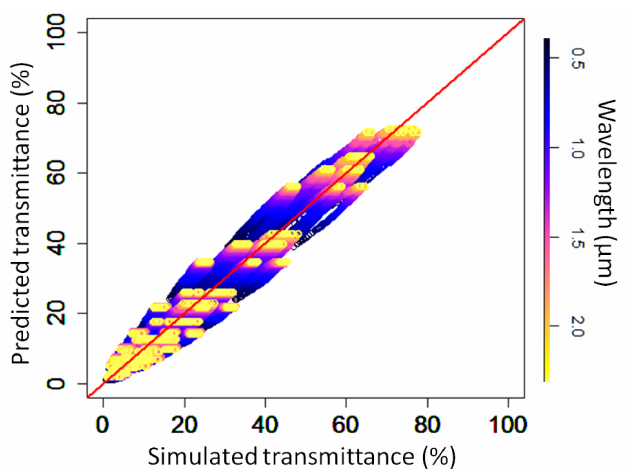
Figure 7. Spectral validation of tree crown transmittance between predictions and simulations for the empirical tree